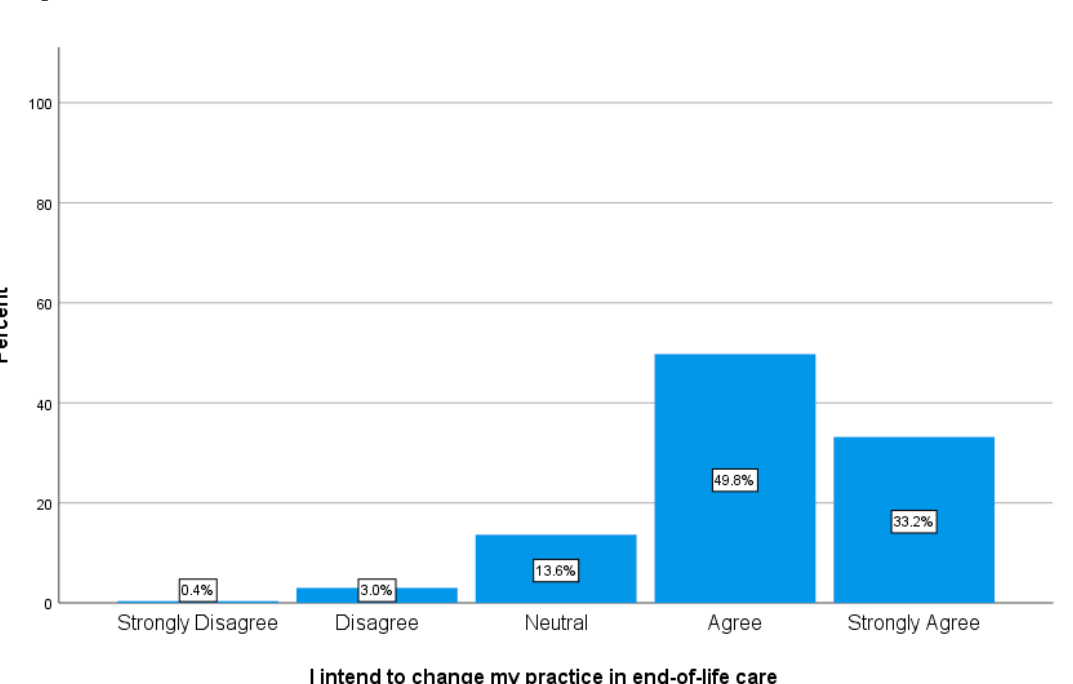
Figure 2. Intention to practice change in providing end-of-life care for patients living with chronic complex illness ( n = 1085).